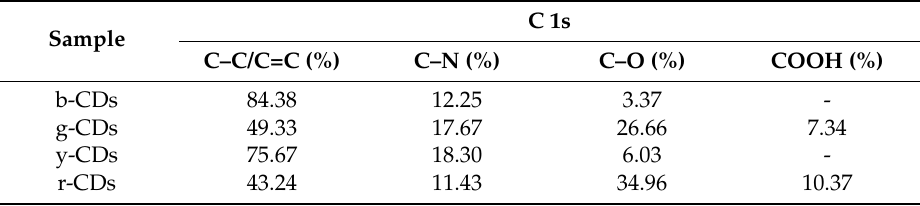
Figure 4. ( a ) Comparison of Fourier transform infrared (FT-IR) spectra of the b-CDs and g-CDs; ( b ) Comparison of FT-IR spectra of the y-CDs and r-CDs; ( c ) Comparison of high resolution of C 1s X-ray photoelectron spectroscopy (XPS) spectra of the b-CDs and g-CDs; ( d ) Comparison of high-resolution C 1s XPS spectra of the y-CDs and r-CDs. Table 1. The quantitative fitting results of C1s XPS for the Table 1. The quantitative fitting results of C1s XPS for the CDs.